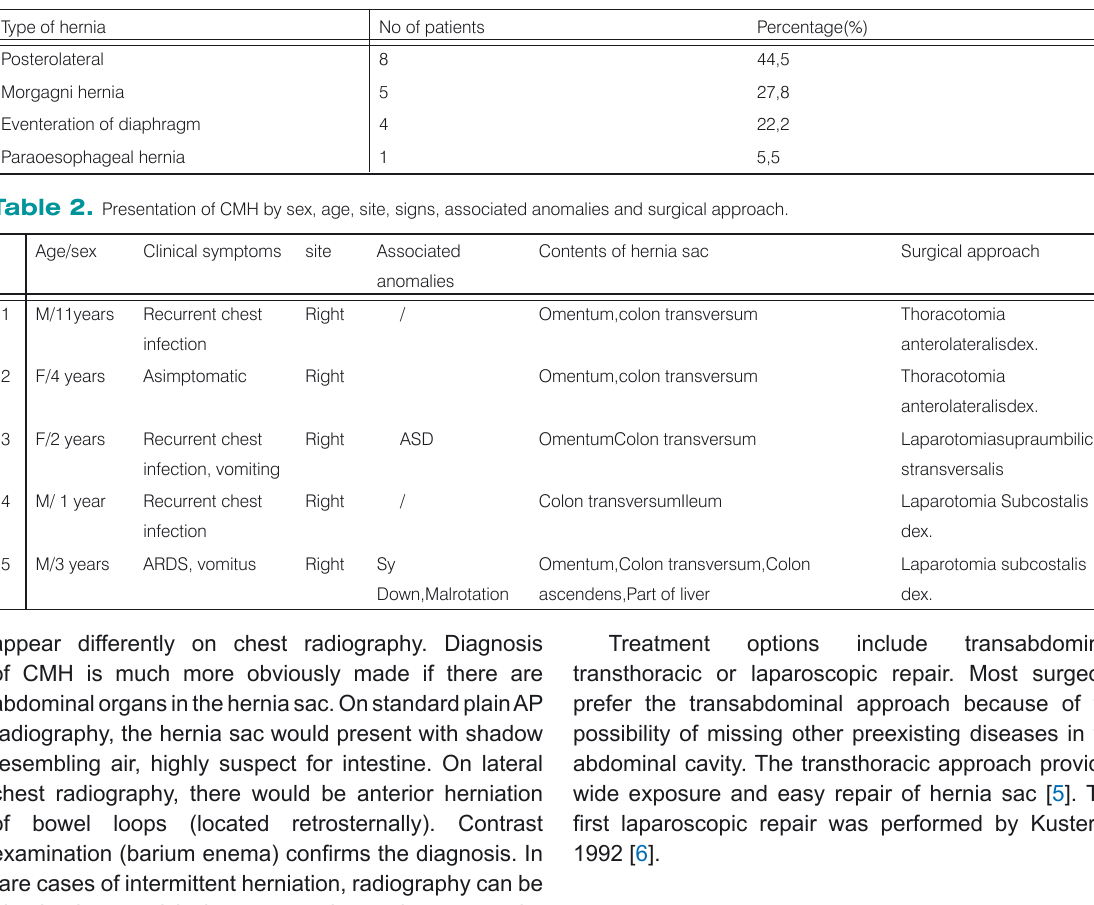
Table 1. All patients with congenital diaphragmatic defects admitted to our hospital from 1988 to 2008.